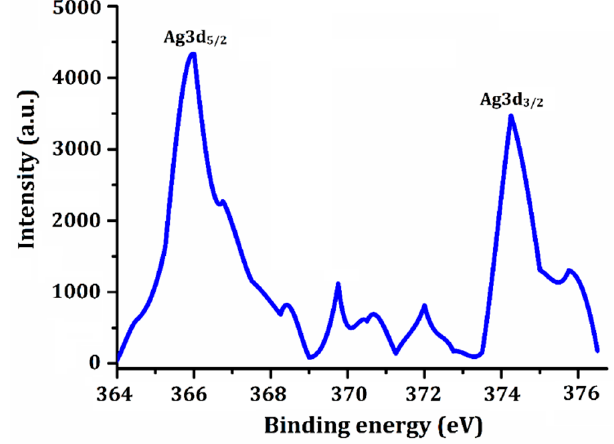
Figure 7. XPS spectra of CR-AgNCs particles.